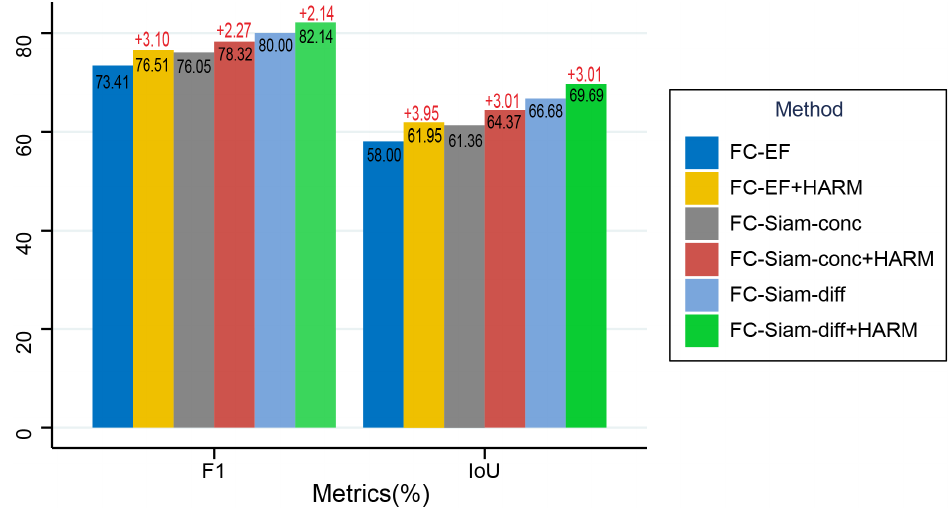
Figure 15. Ablation experiments performed on the LEVIR-CD dataset applying HARM to other models. All scores are expressed as a percentage